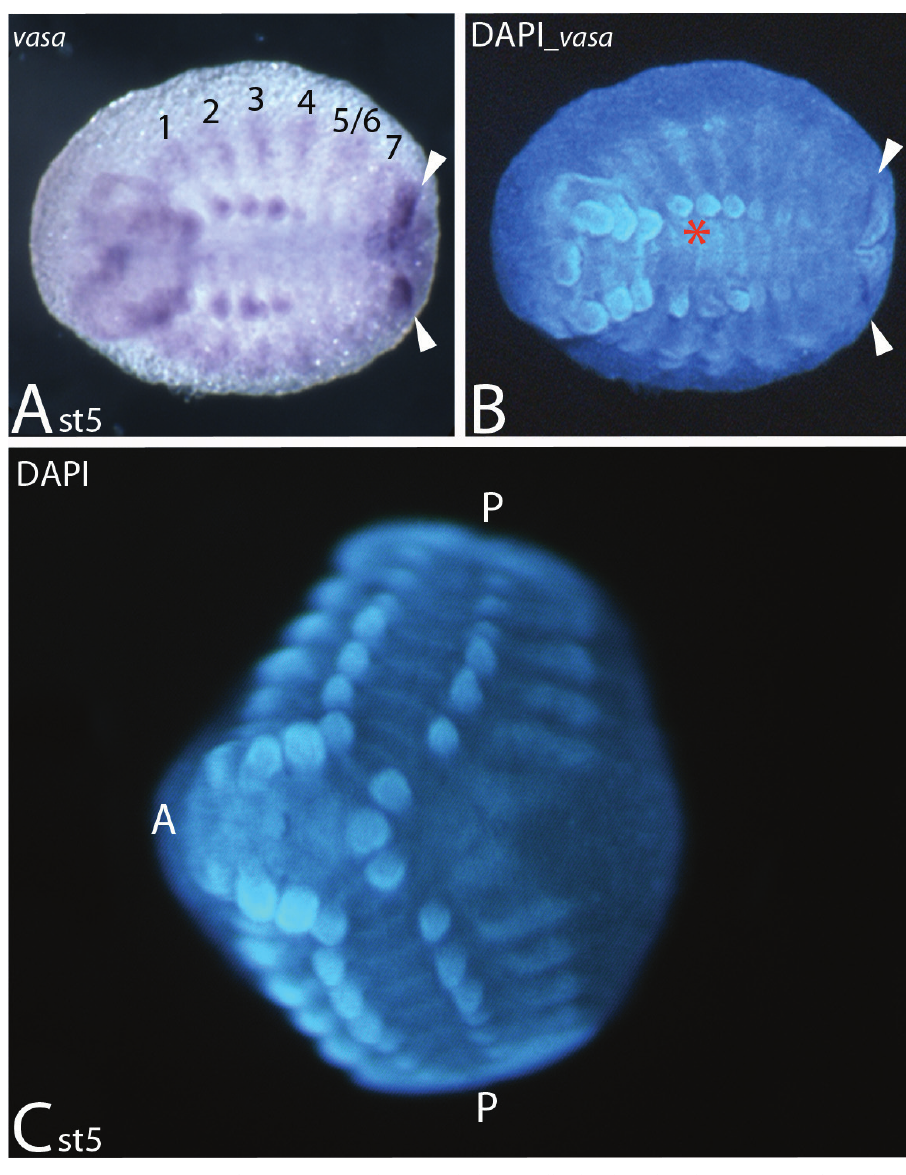
Figure s1. Expression of vasa ( A/B ) and a typical abnormally developed embryo (ADE) of Duplicitas posterior type ( C ). In all panels anterior is to the left. A/B Bright-field and corresponding DAPI-stained embryo. White arrowheads mark strong expression of vasa anterior to the anal valves. Red asterisk marks the position where the minor germ band is connected to the major germ band in the presented ADE (cf. Fig. 1). C Typical D. posterior -type embryo. Abbreviations: 1 to 7, expression of vasa in dorsal segmental units corresponding to ventral trunk segments one to seven; 5/6, first diplosegmental unit corresponding to ventral trunk segments five and six; A anterior pole (head); P posterior pole (anal